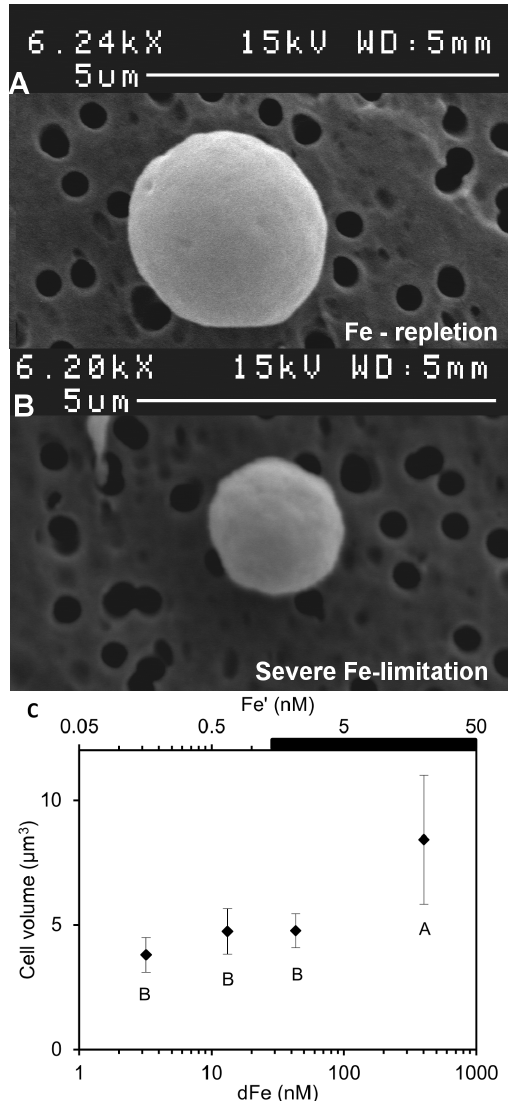
Figure 2. Influence of Fe availability on C.watsonii biovolume. Scanning electron microscopy photography of C. watsonii growing in (A) Fe-replete condition (dFe=403.3 nM) and (B) severe Fe-limited condition (dFe=3.3 nM). (C) Mean biovolume of C. watsonii related to dFe and Fe 9 concentrations, in log scale. Error bars represent standard deviation; different letters correspond to statistically different means ( p , 0.05) and the black bar indicates the region of expected Fe hydroxide